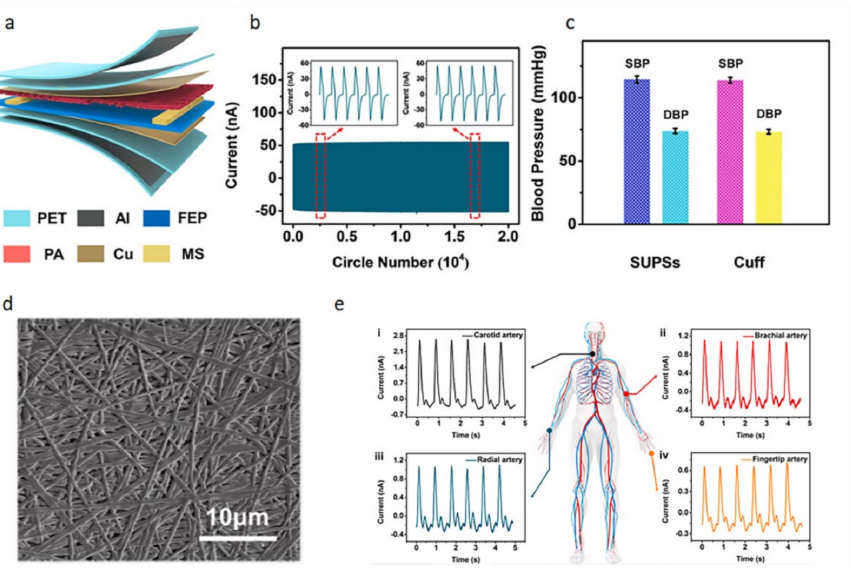
Figure 8. The construction diagram of the sensor and the monitoring diagram of blood pressure and pulse. ( a ) Schematic diagram of the sensor structure; ( b ) cycling stability of the sensor; ( c ) average blood pressure values measured by sensors and electronic sphygmomanometers; ( d ) SEM image of PA nanofiber membrane; ( e ) pulse signal under different arteries [41].